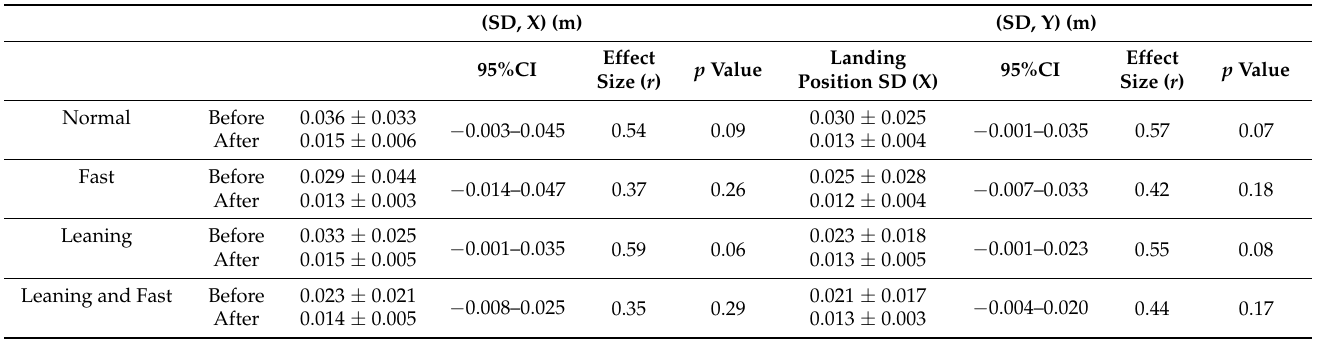
Table 13. Movement variation in the ATG in anterior (SD,Y) and lateral (SD, X) direction of G-foot lateral obstacle